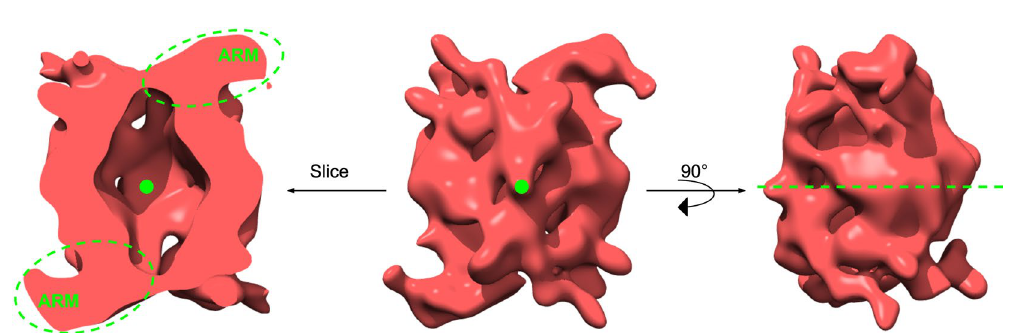
Figure 7. 3D reconstruction of the homodimeric LRRK2. 3D model of LRRK2 at 16.2 Å resolution showing the side-view orientations, the right one being 90 degrees rotated relative to the center one. The left is a cut-away of LRRK2 with the plane of the slice. Also shown are the dimerisation axis between the LRRK2 monomers (green dot and dashed green line). In the left and the central panel, the dimerization axis points towards the reader. In the right panel, it points form left to right along the middle of the molecule. The label for N-Terminal armadillo repeats domain, ARM are depicted in the left panel. The ARM domain here is visible only in the front, due to the perspective display that hides the rear ARM domain behind the